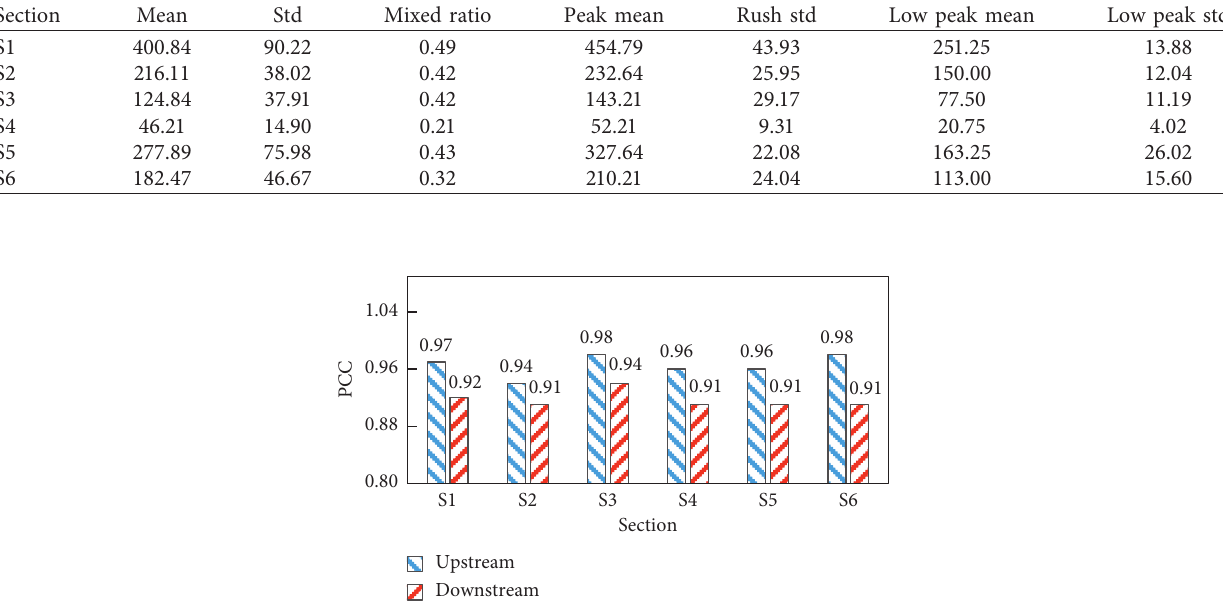
Figure 6: The Pearson correction coefficient with the upstream and downstream